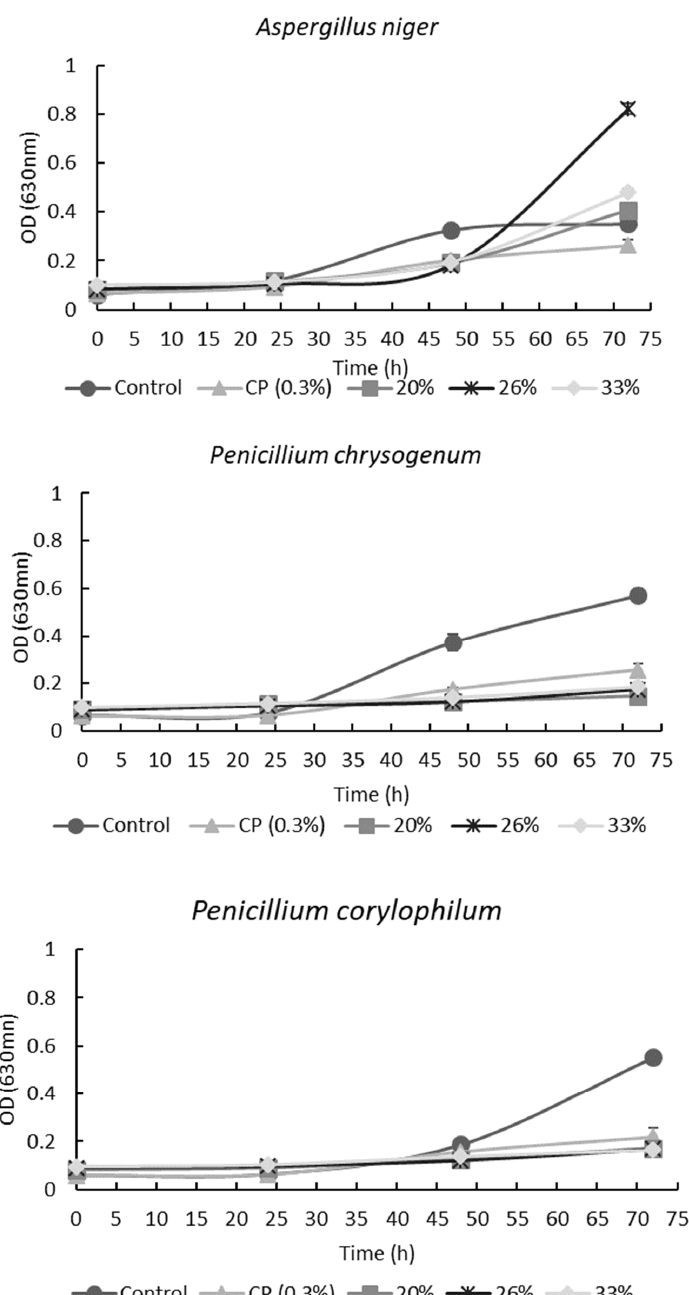
Figure 2. Effect of different concentrations of aqueous extracts from poolish-type sourdough fer- mented with Lactiplantibacillus plantarum NRRL B-4496 at 48 h and calcium propionate (CP) on molds’ growth by optical density at 630 nm.